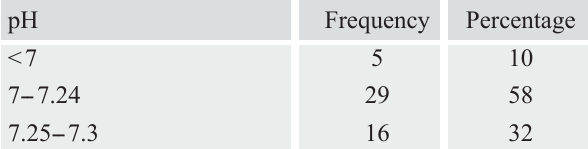
Table III: Precipitating causes of DKA